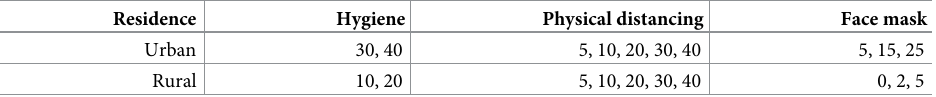
Table 2. Summary of considered adherence level coverage (%) to hygiene, wearing face mask and physical distance in urban and rural population of Ethiopia for numerical simulation.